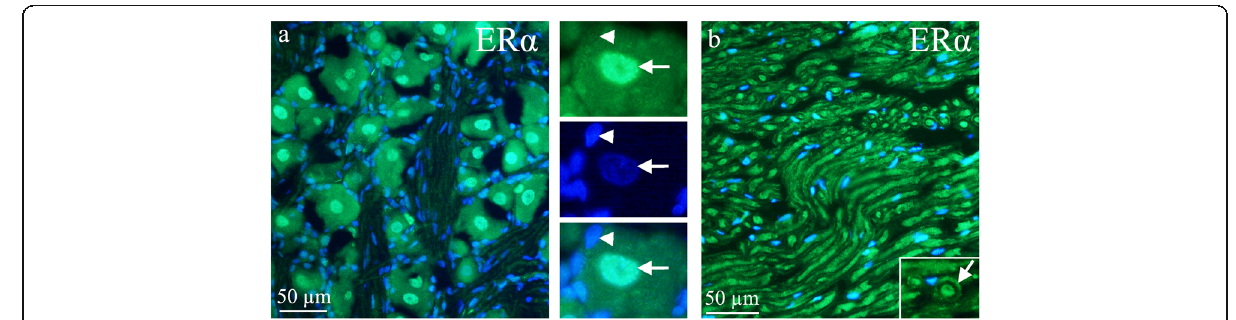
Fig. 5 ER α receptor distribution in the TG. a The neuronal nuclei of the TG express ER α receptor. The montage discloses the neuronal nuclei staining, arrow heads point at a negative nucleus of the glial cells, and arrows at a positive neuronal nucleus. b In the trigeminal nerve, immunoreactivity was found in the nerve fibers. Insert: Perpendicular cut nerve fibers displays an inner immunoreactive fiber (arrow). Outside of the fiber, the myelin sheet showed no